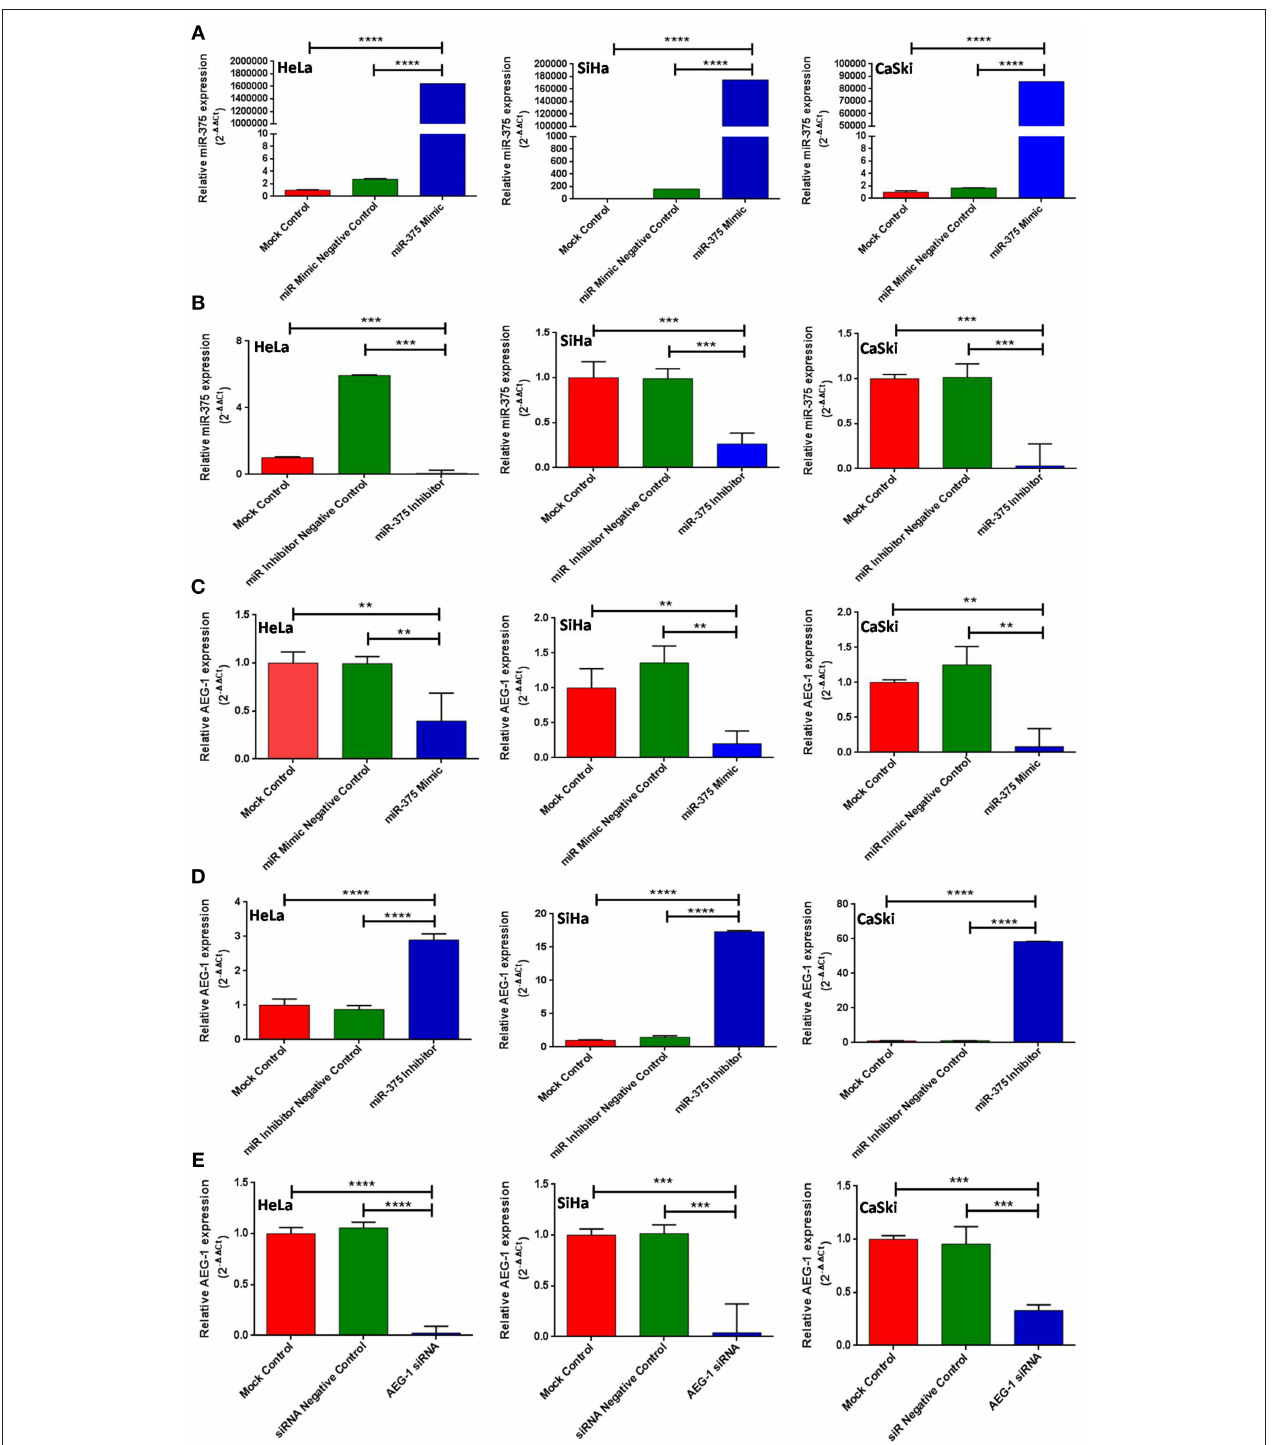
FIGURE 2 | miR-375 regulates AEG-1 expression in cervical cancer cell line. HeLa, SiHa, and CaSki cells were transfected with Mock Control, miR-Mimic Negative Control, miR-Inhibitor Negative Control, miR-375 mimic, miR-375 Inhibitor, siR-Control, and AEG-1 siRNA and the expression level of miR-375 and AEG-1 were estimated by qRT-PCR using RNU6 and GAPDH, respectively, for normalization. miR-375 mimic increased endogenous miR-375 expression in CC cells (A) miR-375 Inhibitor decreased endogenous miR-375 expression (B) . Ectopic expression of miR-375 decreased AEG-1 mRNA expression (C) AEG-1 mRNA expression increased while inhibiting endogenous miR-375 by using miR-375 inhibitor (D) . AEG-1 siRNA decreased AEG-1 mRNA expression (E) in CC cells. Error bars represent mean ± s.d. and P- values are represented as ** P < 0.05, *** P < 0.001, **** P < 0.0001 compared to the corresponding controls.